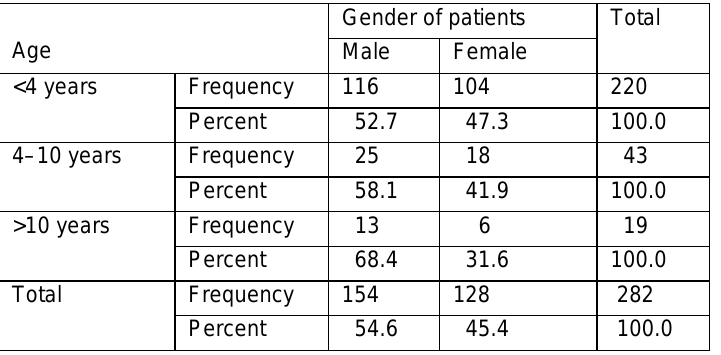
Age and Gender Distribution of Bedouin Children Hospitalized for Burns Gender of patients